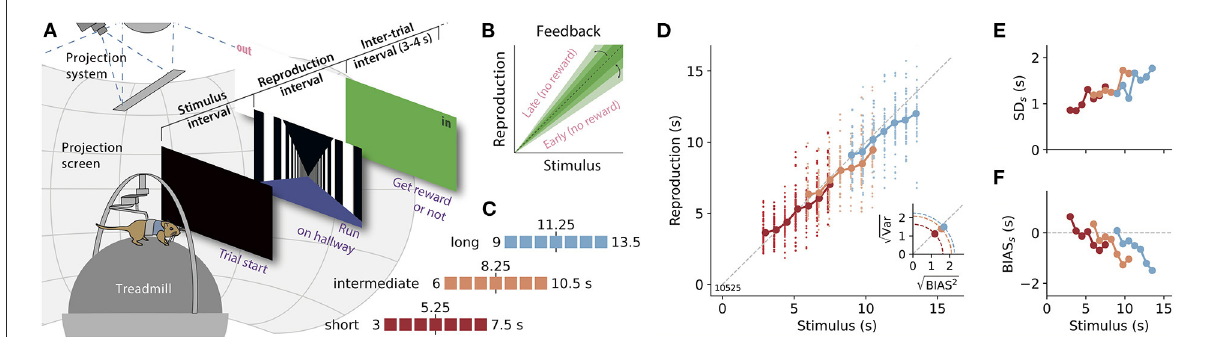
FIGURE1 A time reproduction task for rodents. (A) Experimental apparatus and task. A gerbil was placed on a treadmill surrounded by a projection screen. Trials started with a timed stimulus (black screen). Then a virtual corridor appeared and the animal had to reproduce the time interval by walking. If the reproduction was close to the stimulus duration (“in”), a food reward was delivered and the entire screen was set to green for 3–4 s before another trial was initiated; otherwise, the screen was set to white (“out”). (B) The range for positive feedback, i.e., the error-tolerance window, was narrowed/widened after each in/out response. (C) Stimulus durations for one session were randomly sampled from one of three discrete uniform distributions with seven values each. Upper and lower borders are given as numbers. These stimulus ranges differed only by their mean values (marked by a vertical black solid line and a number). Colors identify range and will be used throughout the article. (D) Time reproductions of an example gerbil. Individual reproduced values are given as small dots and averages for each stimulus as large dots connected by a solid line. Gray dashed line marks equality. Inset: Square roots of the average variance (i.e., the SD) vs those for average squared bias for the three stimulus distributions. The distance from the origin of the coordinate system is the RMSE. Along the dashed quarter circles, RMSE would be constant. (E) SD for each stimulus duration (SD s ). (F) Average bias, i.e., response stimulus, for each stimulus (BIAS s −